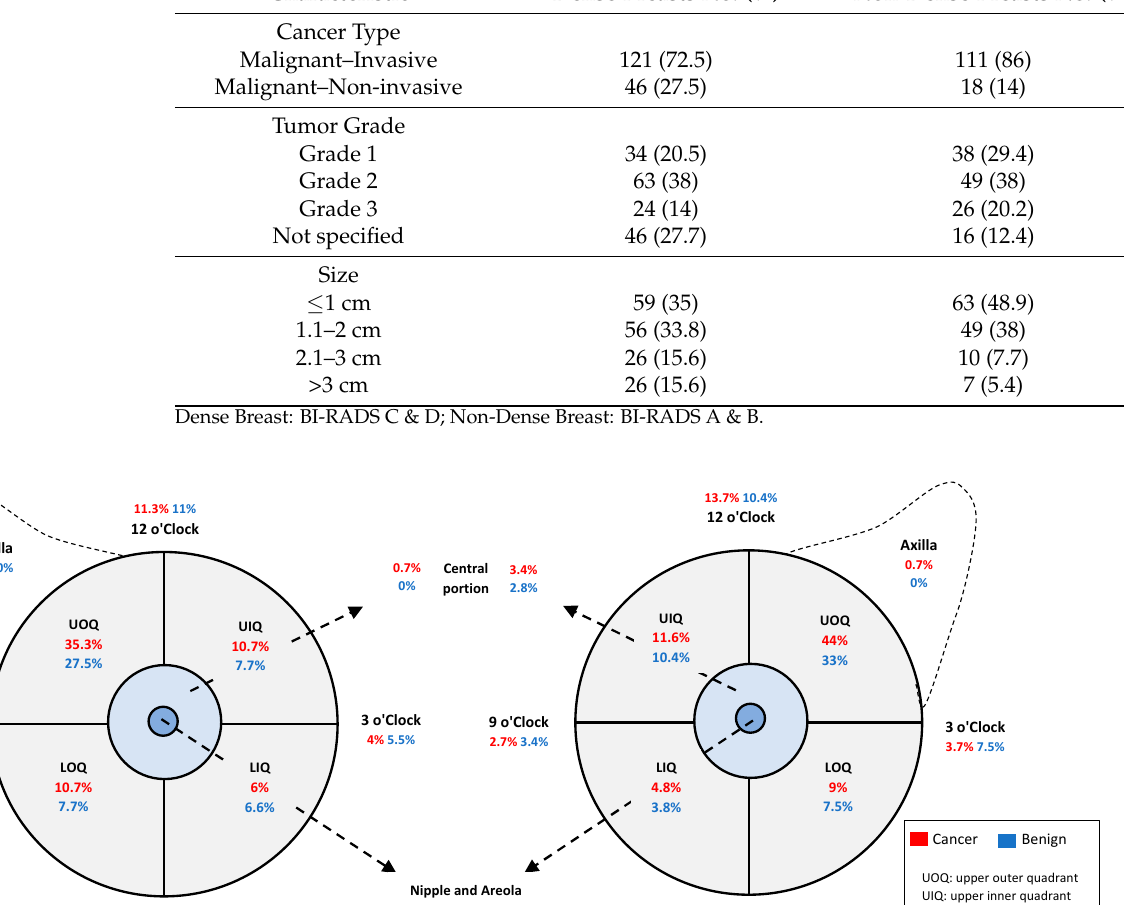
UOQ: upper outer quadrant UIQ: upper inner quadrant LOQ: lower outer quadrant LIQ: lower inner quadrant